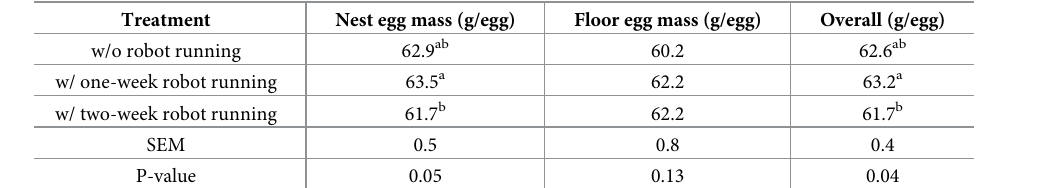
Bone quality Table 6 shows the means of parameters for evaluating bone quality of hens. The average bone breaking force, fresh bone weight, dried bone weight, bone ash weight, and ash percentage were 24.8 kg, 11.0 g, 7.3 g, 4.1 g, and 56.0%, respectively, and they were not significantly differ- ent among treatments (P � 0.20). Table 3. Egg mass under the treatments.